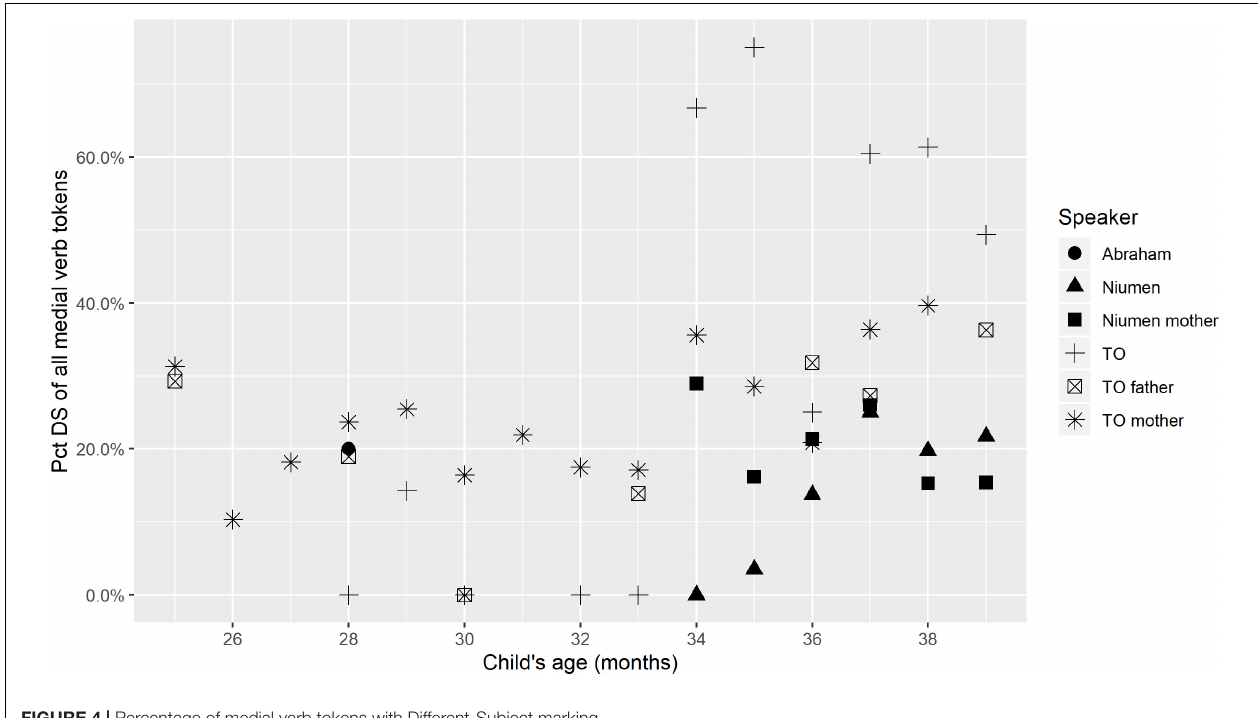
FIGURE 4 | Percentage of medial verb tokens with Different-Subject marking.